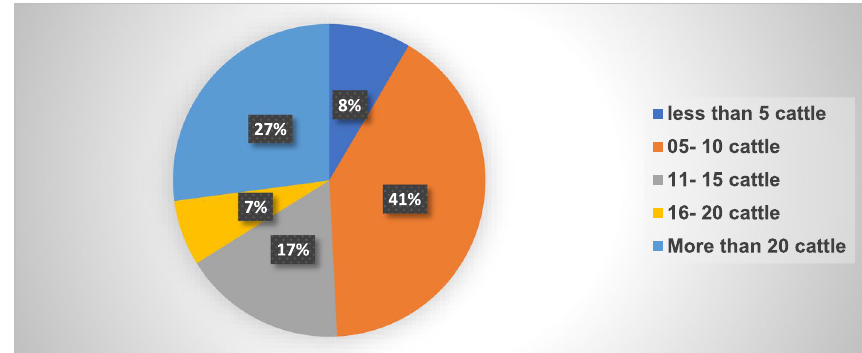
Fig. 2 Distribution of cattle in the three studied communal areas